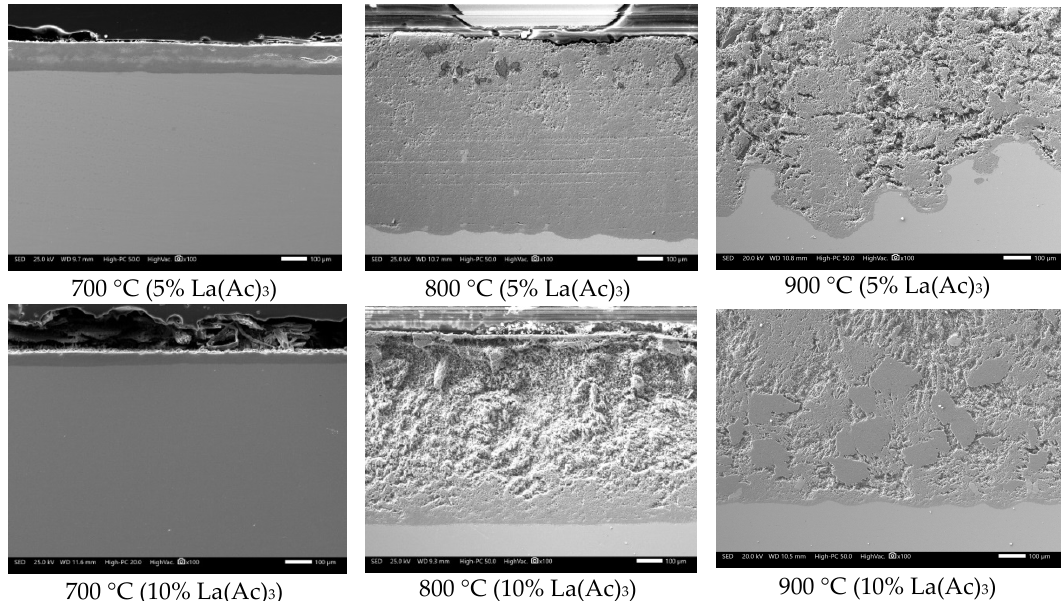
Figure 4. Cross-sectional aspect of 304H steel after corrosion testing for 100 h in NaVO 3 with the addition of lanthanum acetate.